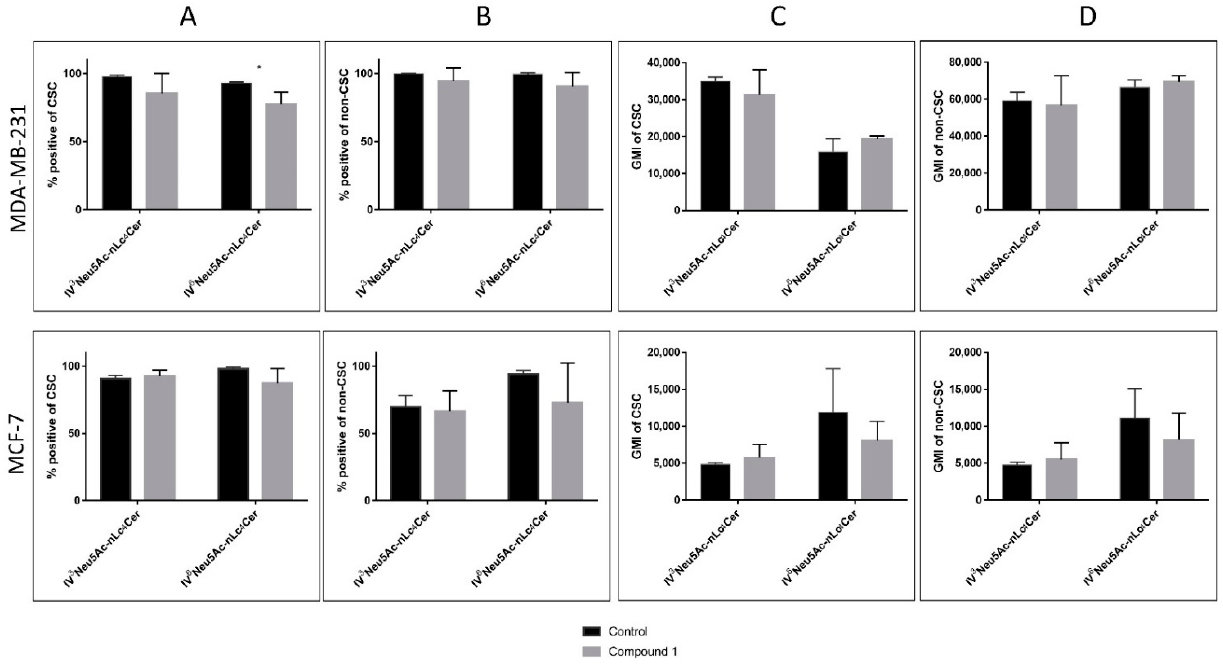
Figure 5. Percentage and geometric mean fluorescence intensity of terminally sialylated ganglioside- positive cell subpopulations. Notes: Percentage of CSCs in the MDA-MB-231 and in the MCF-7 ( A ), and non-CSCs in MDA-MB 231 and in the MCF-7 ( B ). Geometric mean fluorescence intensity of CSCs in MDA-MB 231 and in the MCF-7 ( C ), and non-CSCs in the MDA-MB-231 and in MCF-7 cell lines ( D ) after treatment with compound 1 in duration of 48 h. Data are expressed as a mean from experiment performed in triplicate ± SD. Columns, mean of viable cells; bars, SD; * p < 0.05. CSC, CD44 + /CD24 − cells; non-CSC, CD44 + /CD24 + , CD44 − /CD24 − and CD44 − /CD24 + cells; GMI, geometric mean fluorescence intensity; SD, standard deviation. The designation of the gangliosides follows the IUPAC- IUB recommendations [32] and the nomenclature of Svennerholm [33]: Neu5Ac, N -acetylneuraminic acid; nLc4Cer, neolactotetraosylceramide; IV 3 Neu5Ac-nLc4Cer; IV 6